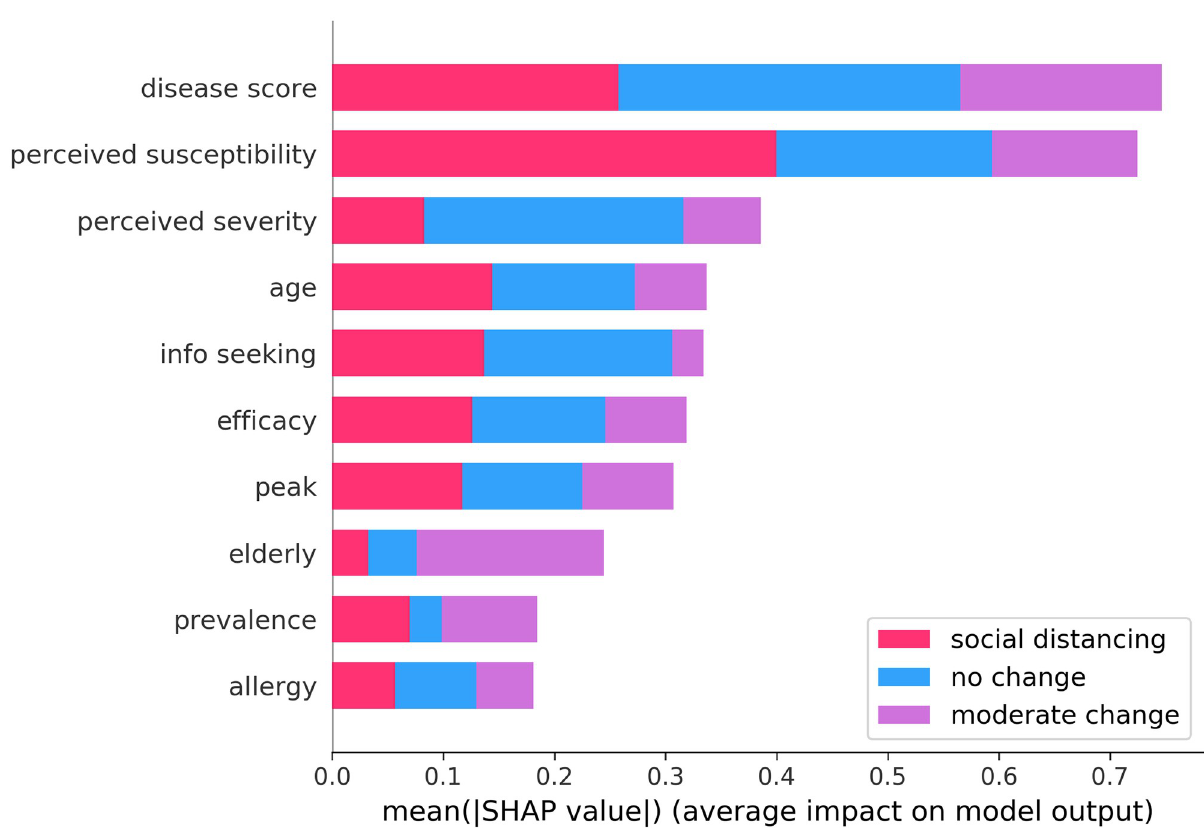
Fig 3. Summary plot for SHAP analysis. It shows the mean absolute SHAP value of ten most important features for the three